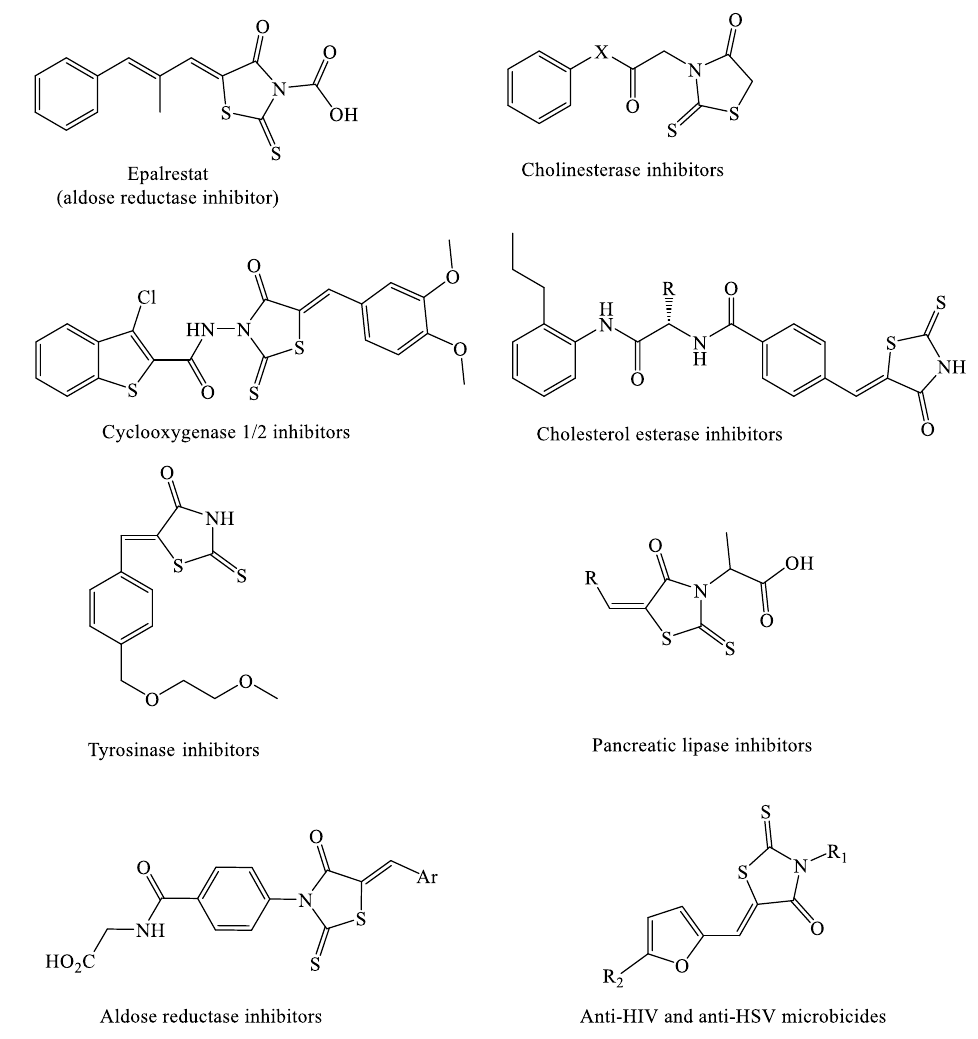
Figure 1. Biological activities of some selected examples of reported rhodanines [2,4,7,9,10,12,14,15].